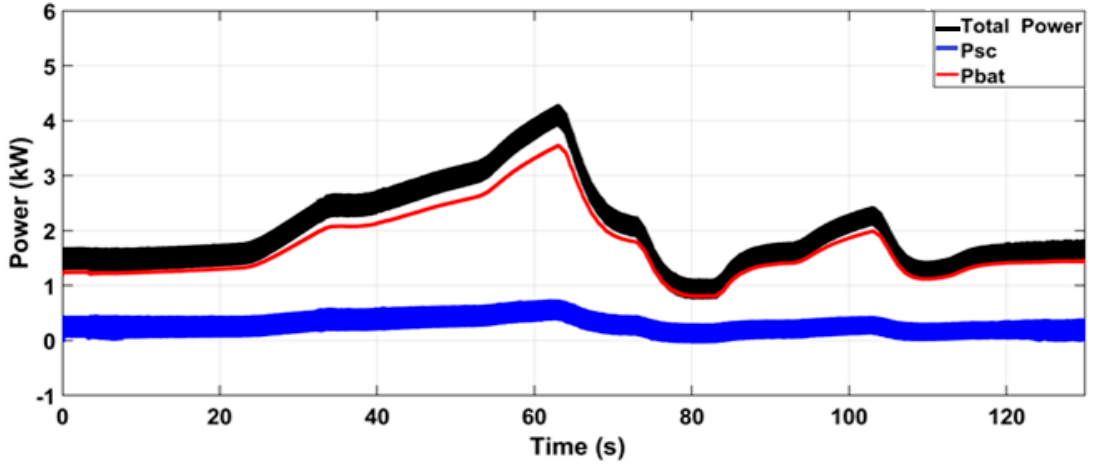
Figure 15. Power of the battery and the supercapacitor.